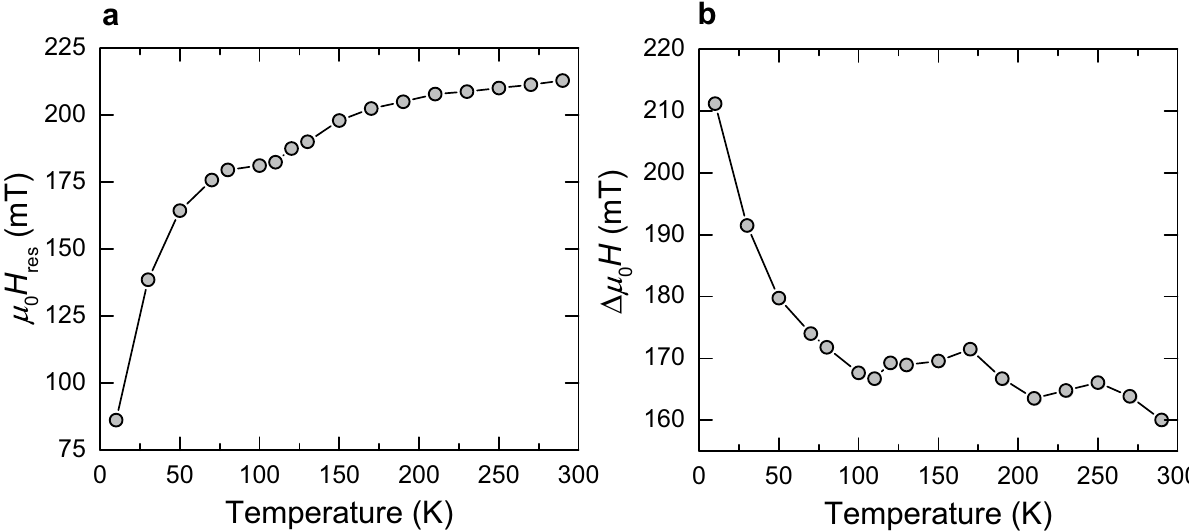
Figure 5. Development of the spectral parameters at low temperatures. ( a ) μ 0 H res and ( b ) Δ μ 0 H showing pronounced changes at T ≈ 50